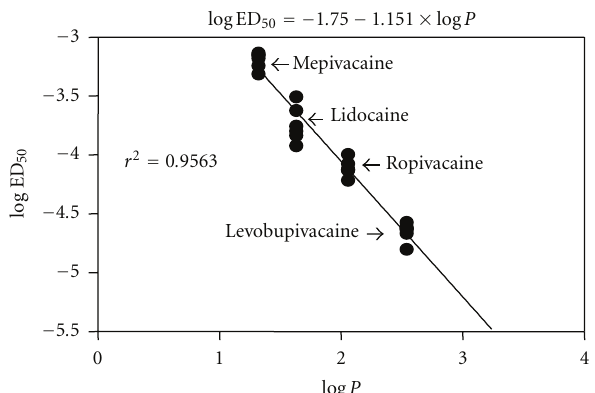
Figure 2: Relationship between logarithm of local anesthetic concentration producing 50% of the local anesthetic-induced maximal contraction (ED 50 ) in isolated endothelium-denuded aorta and logarithm of octanol/bu ff er partition coe ffi cient (log P ) of local anesthetics. All values are shown as mean ± SD. Each anesthetic was tested in aortic rings from six